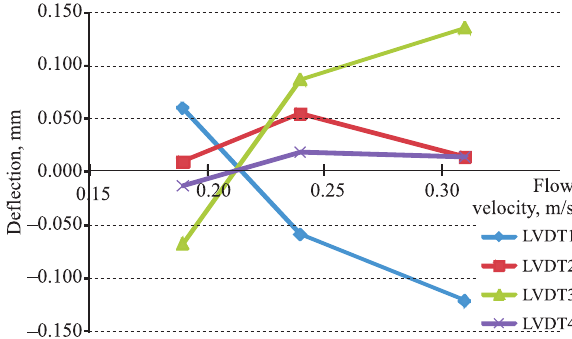
Fig. 18. Effect of flow velocity on slab deflection when the load was at mid-span